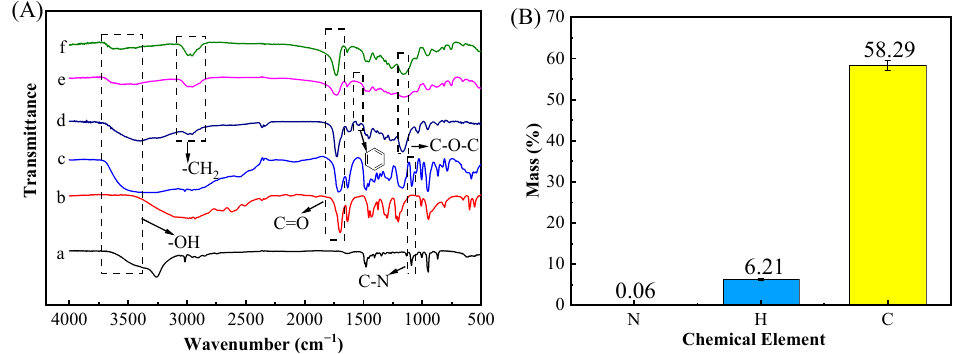
Figure 3. FT-IR spectra ( A ) of materials including ChCl (a), MAA (b), DES (c),